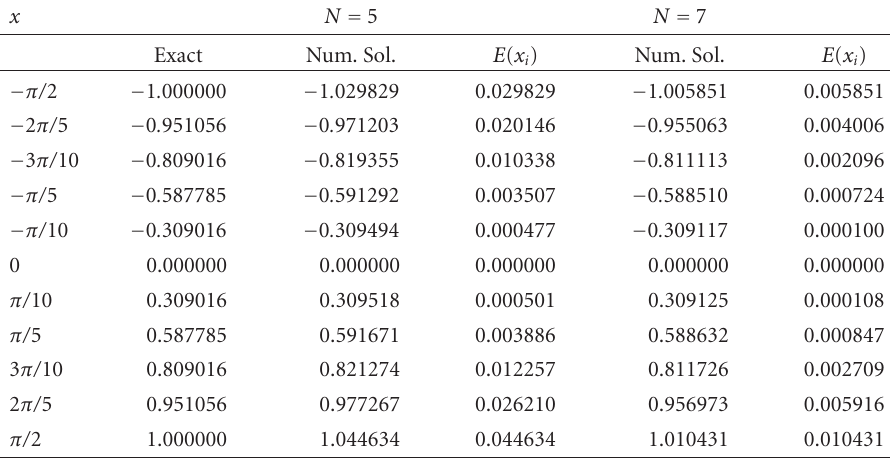
Table 4.2. Error analysis of Example 4.2 for the x